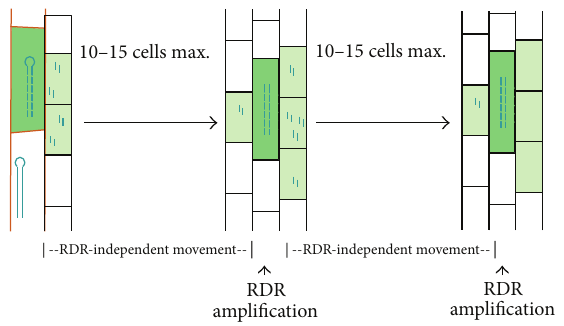
F 3: RDR-independent and RDR-dependent spreading of siRNAs. siRNAs can spread about 10 to 15 cell layers. Further spreading requires